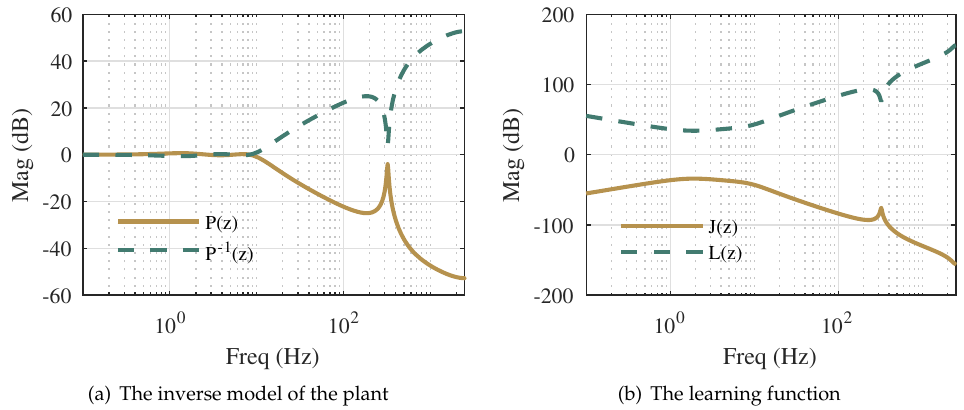
Figure 7. Amplitude frequency responses for the inverse model of the plant and the learning function.